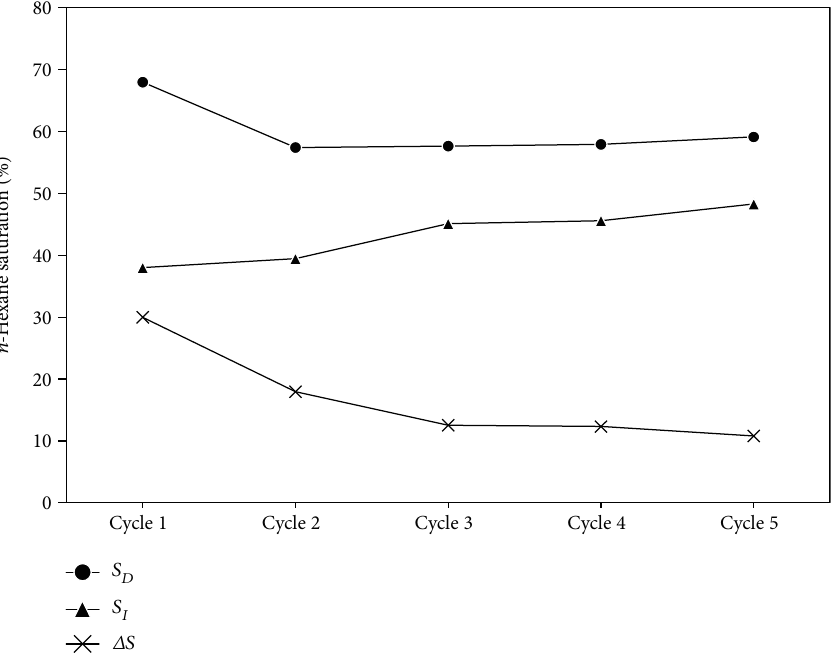
Figure 7: Saturation changes during cyclic injection of hexane and